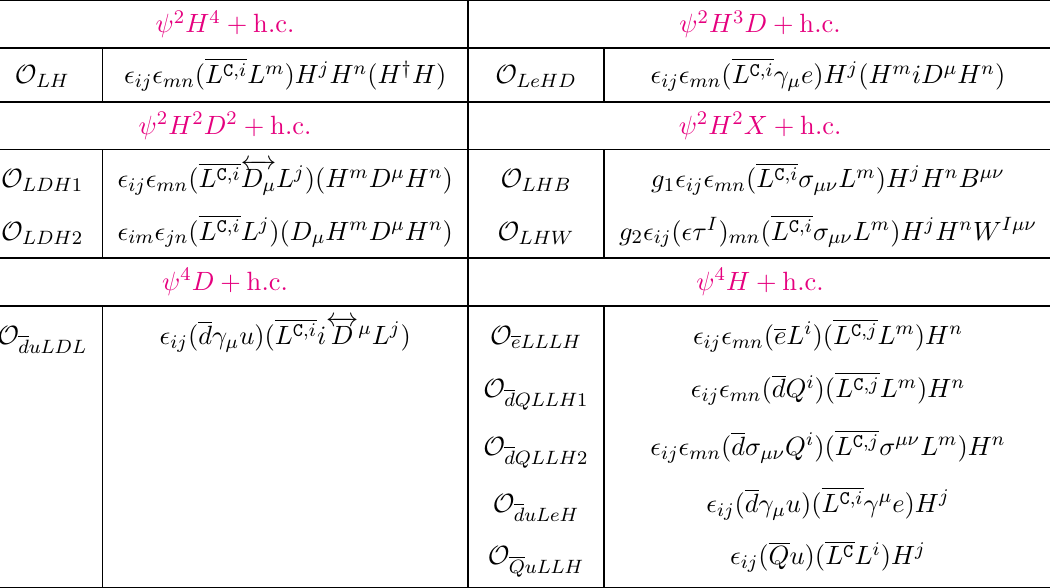
Table 5 . Basis of dim-7 lepton operators that conserve baryon number in SMEFT [64]. Here D µ H n is understood as ( D µ H ) n ,